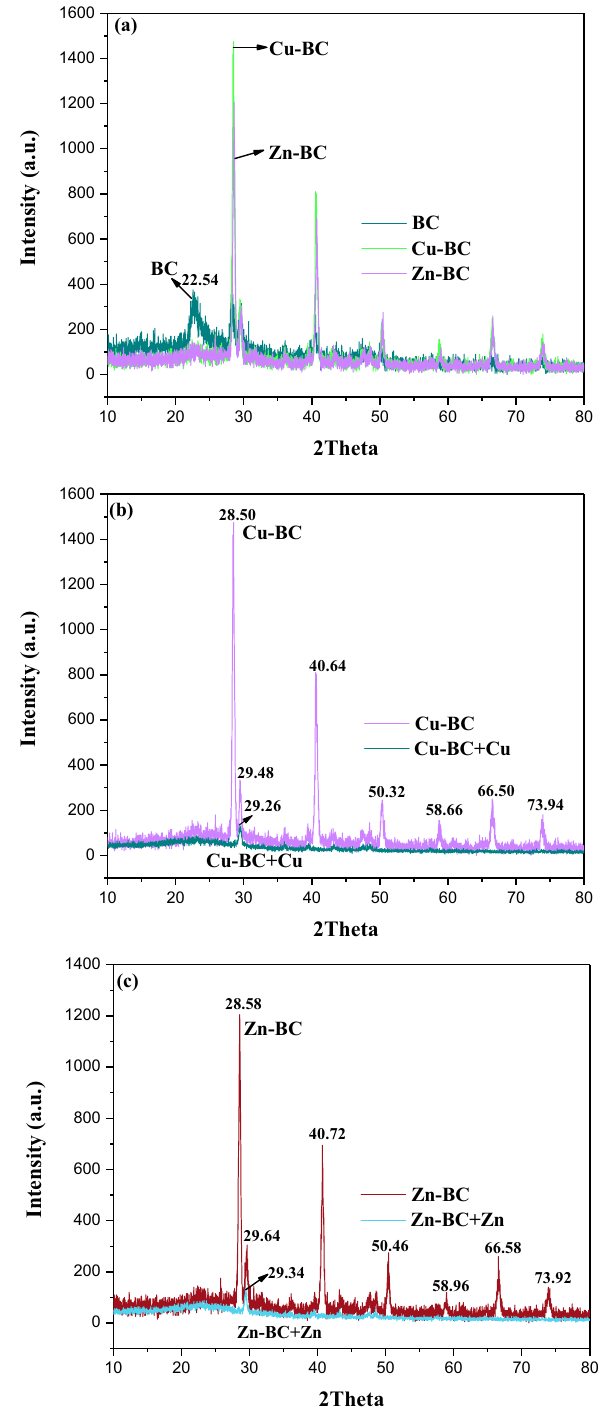
Figure 12. XRD spectra of ( a ) BC, Cu-BC and Zn-BC; ( b ) Cu-BC and Cu-BC + Cu; ( c ) Zn-BC and Zn-BC +